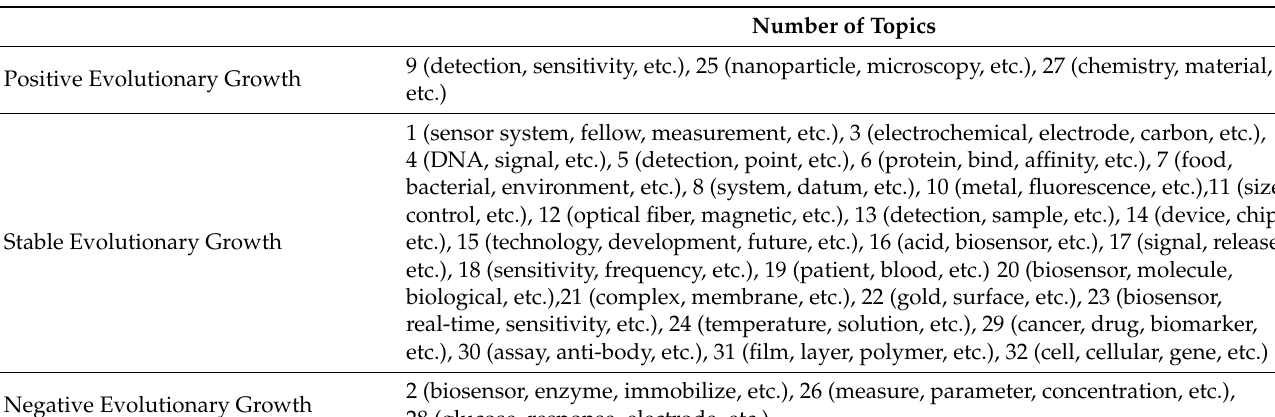
Table 6. Dynamics of trends in biosensors using trend analysis.